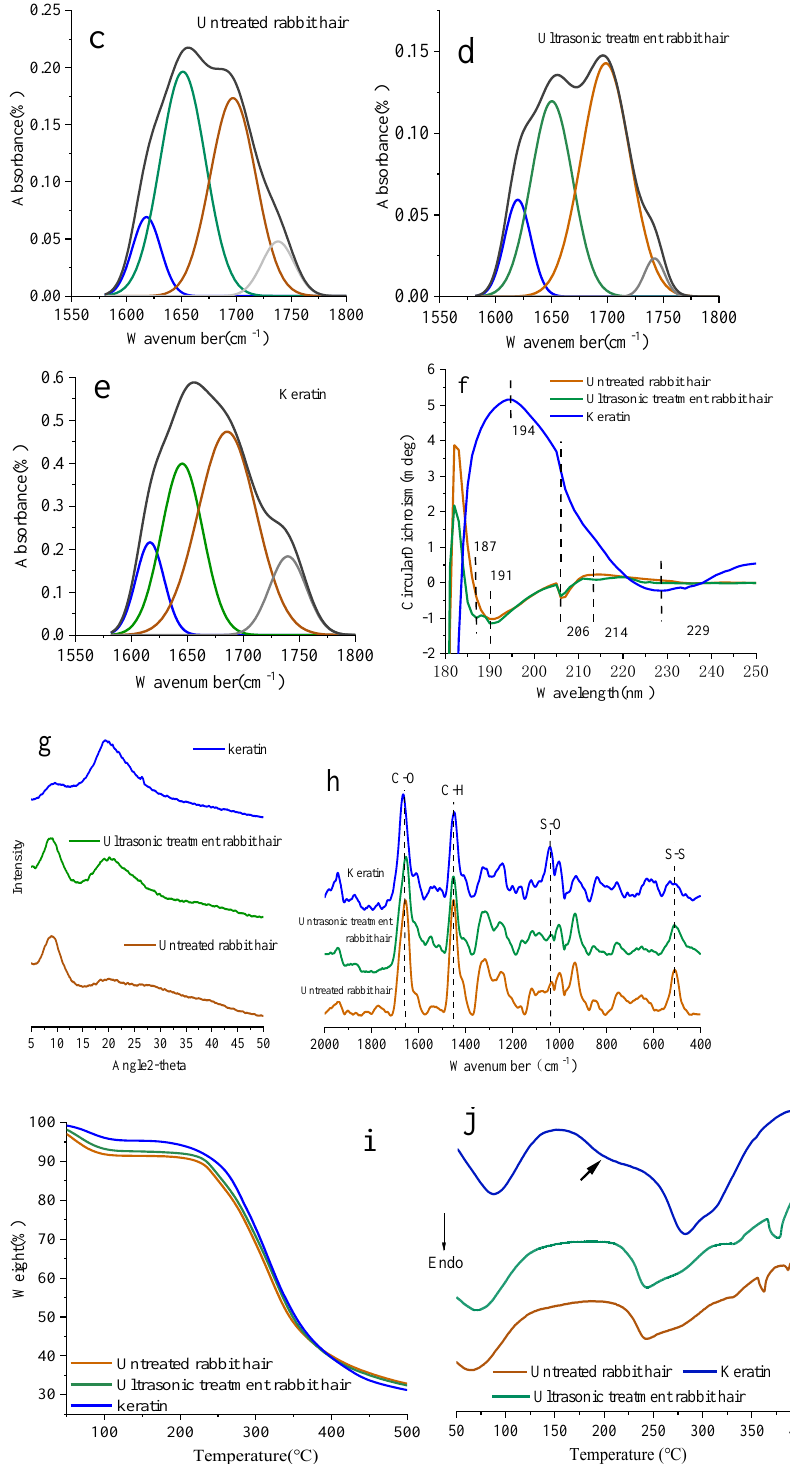
Figure 4. Structural characterization of extracted keratins: ( a – e ) FTIR spectra, ( f ) Circular dichro- ism (CD) spectrum, ( g ) X-ray diffraction (XRD), ( h ) Roman spectra, ( i ) TGA, ( j ) DSC.